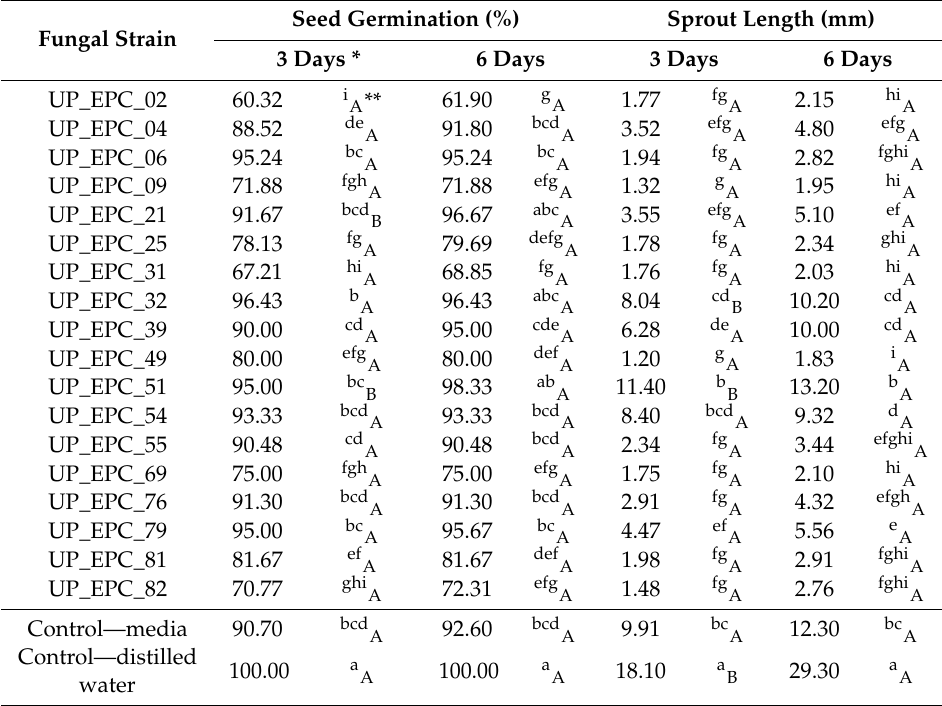
Table A1. E ff ect of the culture filtrates from 18 strains of E. nigrum on seed germination and sprout